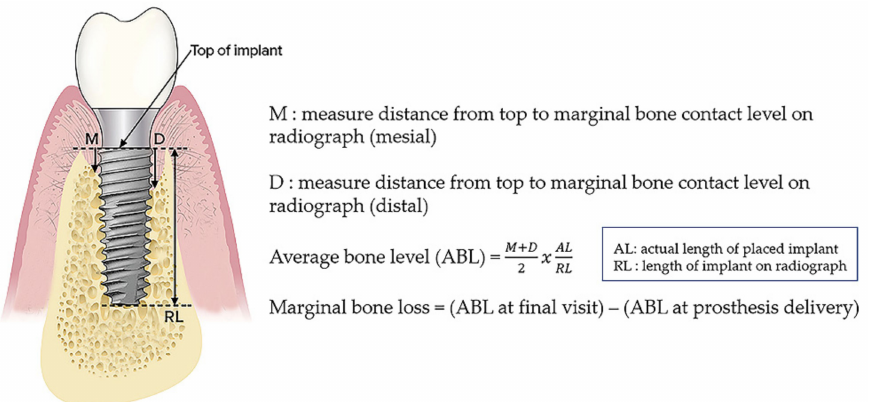
Figure 2. Definition of MBL (marginal bone loss) around